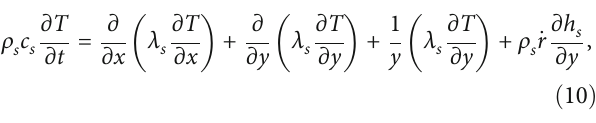
Table 2: Simulation conditions.